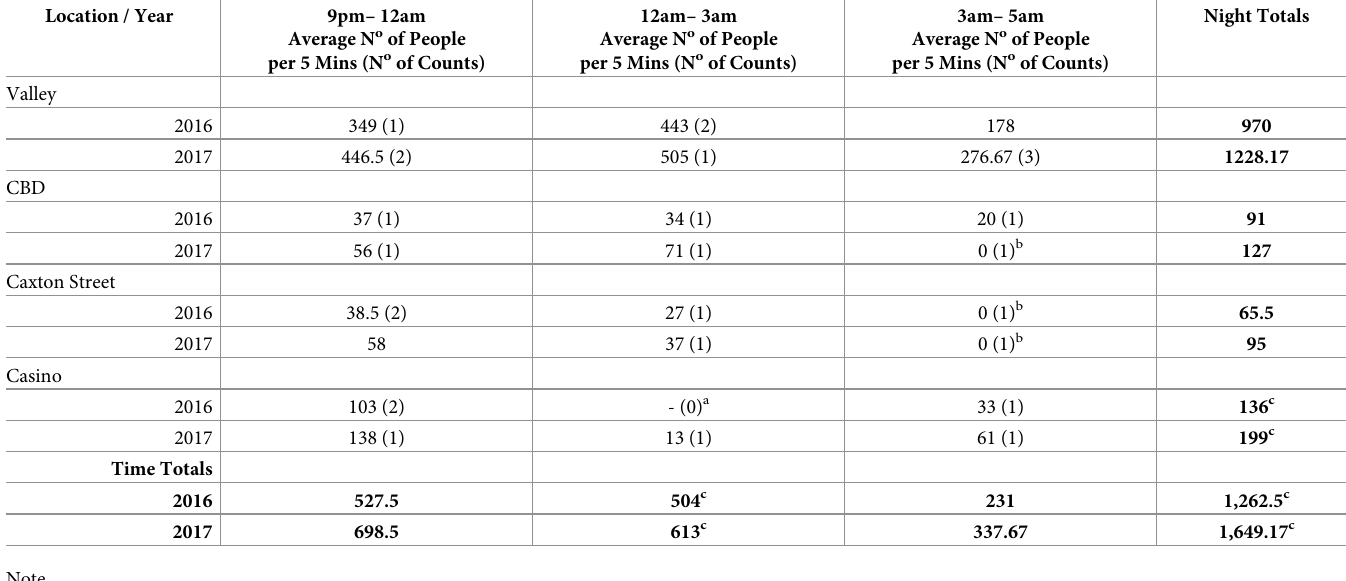
to 2017 by 30.63% (see Table 4) Club numbers. Table 5 presents the averaged numbers inside the clubs, as reported by the clubs to the police Inspector. Looking at the totals for the three timeframes from the same night clubs, it became evident that there were more people in the clubs after the legislation Table 4. Big night out street